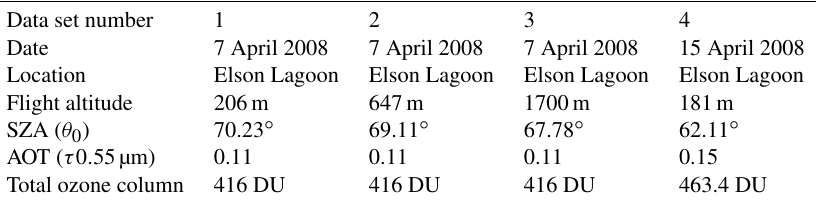
Table 1. Summary of the CAR, Aerosol Robotic Network (AERONET) aerosol optical thickness (transferred from 0.5 to 0.55µm), and weighting function differential optical absorption spectroscopy (WFDOAS) ozone data used in this study. Note: solar zenith angle – SZA. Data set